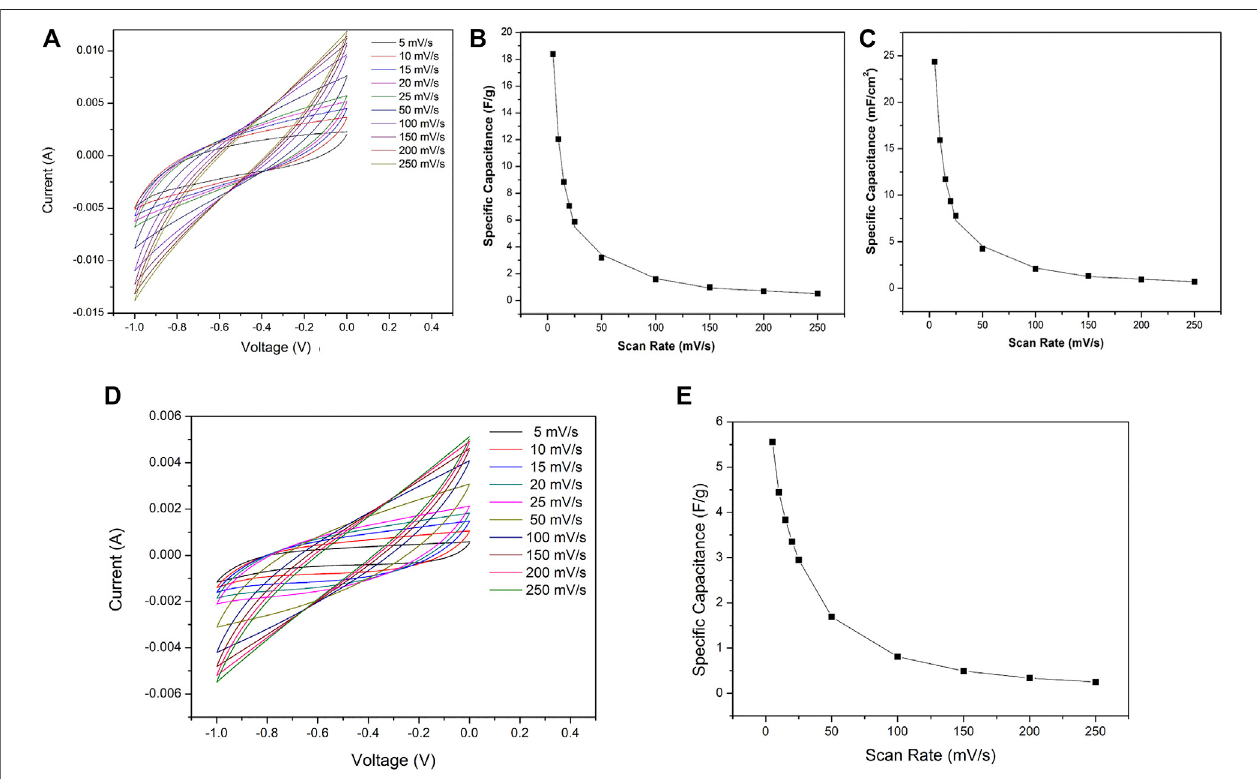
FIGURE 7 | (A) CV curve of the coin cell device fabricated with as synthesized rGO electrode in two electrode con fi gurations obtained by the reduction with ascorbicacid. (B) Calculatedmassspeci fi ccapacitanceatdifferentscanrates. (C) Calculatedarealspeci fi ccapacitanceatdifferentscanrates. (D) CVcurveofacoincell device fabricated by electrode material of bare activated carbon and (E) calculated mass speci fi c capacitance at different scan